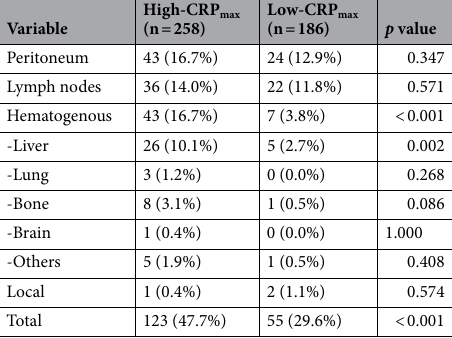
Table 4. Recurrence